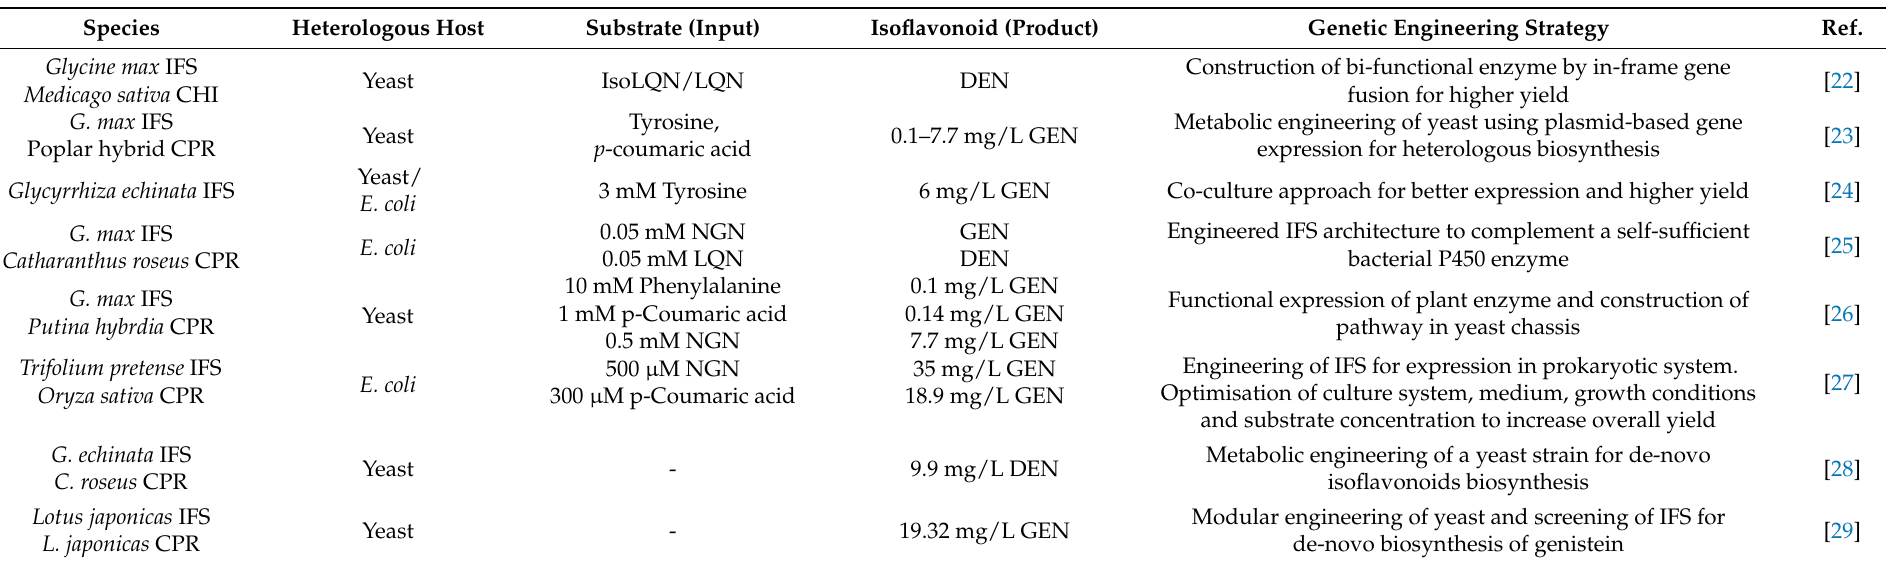
Table 1. Heterologous expression of IFS in